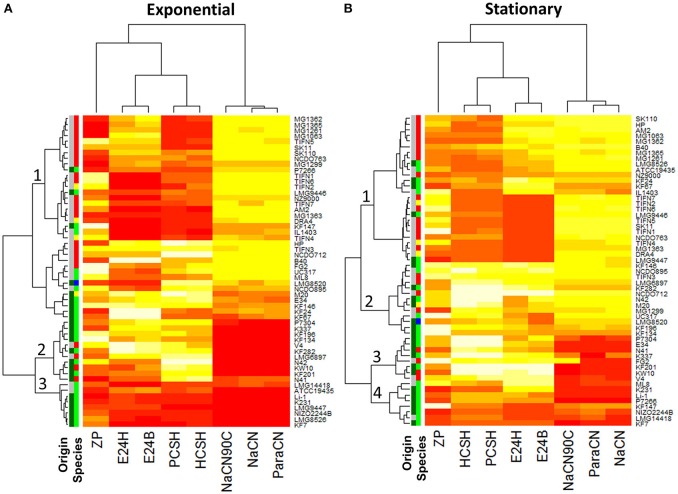
Heat map of surface properties of 55 Lactococcus lactis strains: cell charge (ZP), hydrophobicity measured with petroleum (PCSH) or hexane (HSCH), emulsion stability measured after 24 h (E24B—measured with Petroleum or E24H—measured with Hexane), attachment to milk proteins: para-caseinate (ParaCN), sodium caseinate (NaCN), and sodium caseinate heated for 10 min at 90°C (NaCN90C). (A) Comprises results using the cells from the exponential growth phase, while for (B) cells from the stationary growth phase were taken. Low values are represented by a darker/red color while higher values are represented by a lighter/yellow color of the heat map segment (n = 3). For the charge (ZP) a darker color represents more negatively charged cells. The Origin/Species columns, respectively, indicate plant (green) or dairy (gray) origin and the species lactis (green), cremoris (red), hordniae (blue), or lactis biovar diacetylactis (yellow).